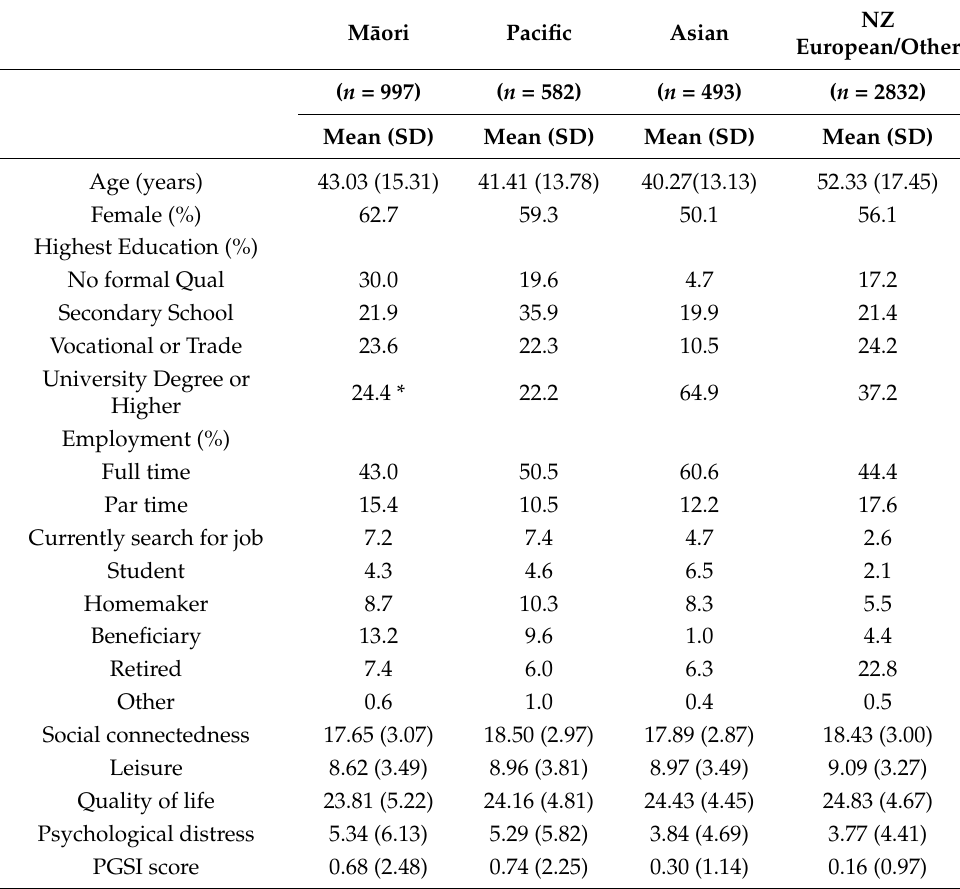
Table 1. Demographic and outcome measures across groups.